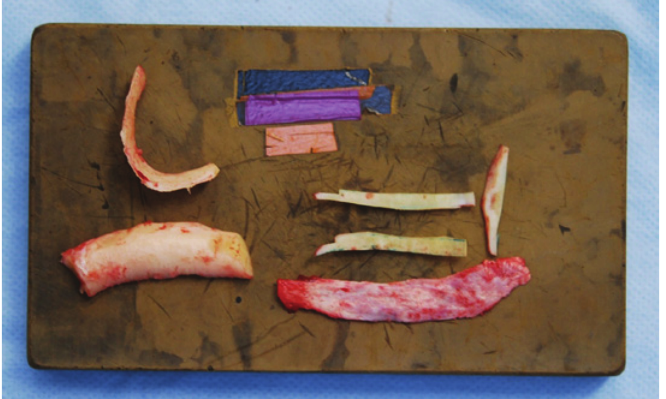
FIGURE 3 - Costal cartilage grafts can become deviated (left side). Septum grafts are straighter (right side). The outer layer of the rib (perichondrium) can be seen below as a thin strip. The grafts were completely beveled and it’s medial aspect was oblique (Figure 4).